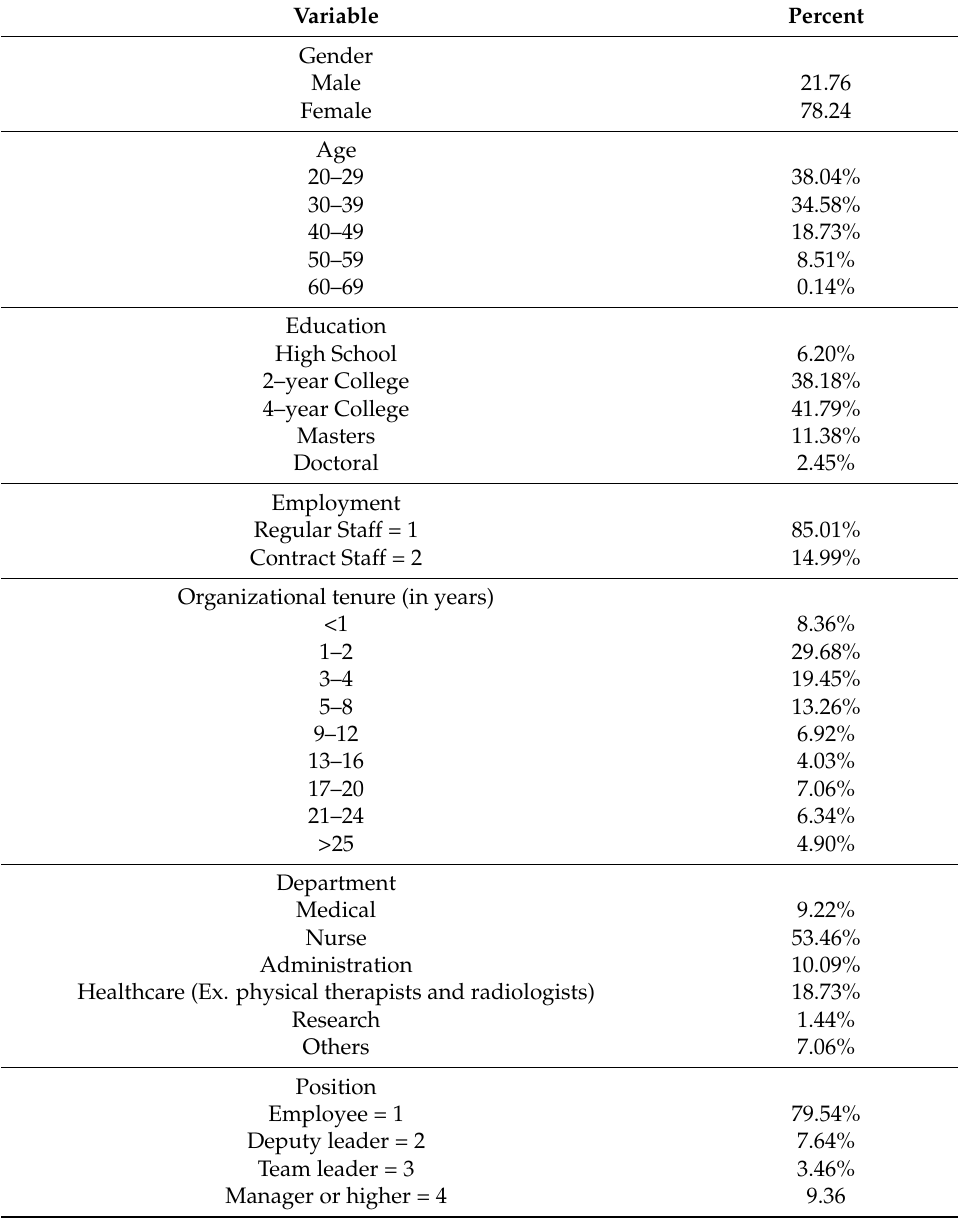
Table 1. Demographic characteristics of the sample.